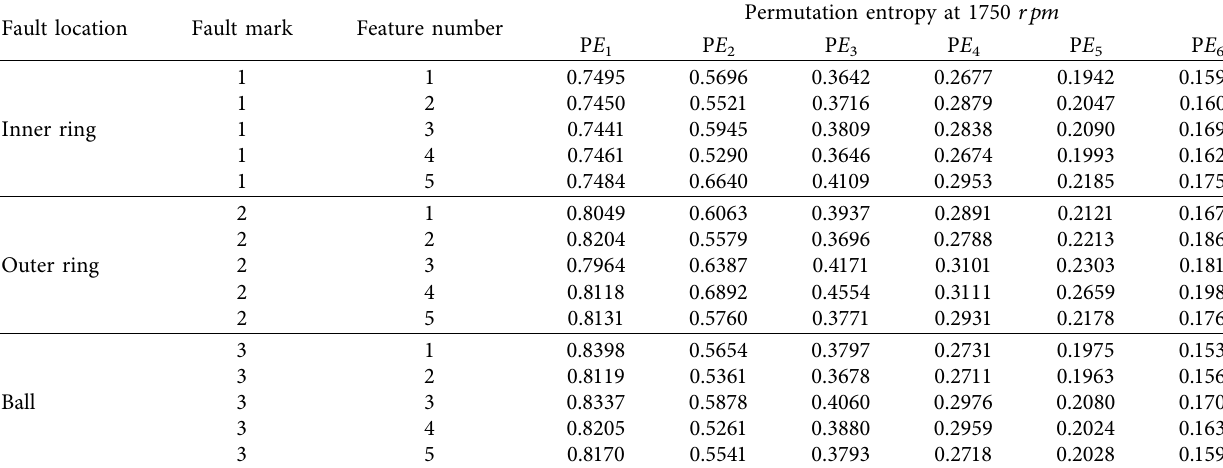
Table 6: Permutation entropy at 1750 rpm.